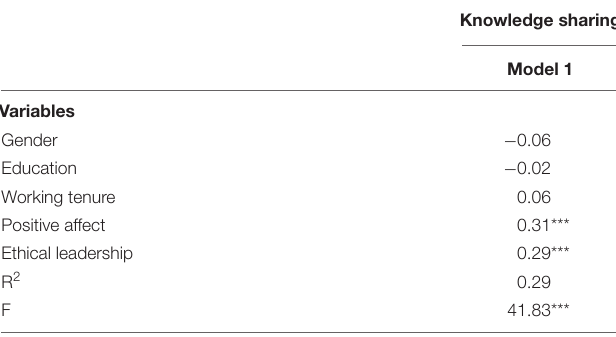
TABLE 2 | Result of regression